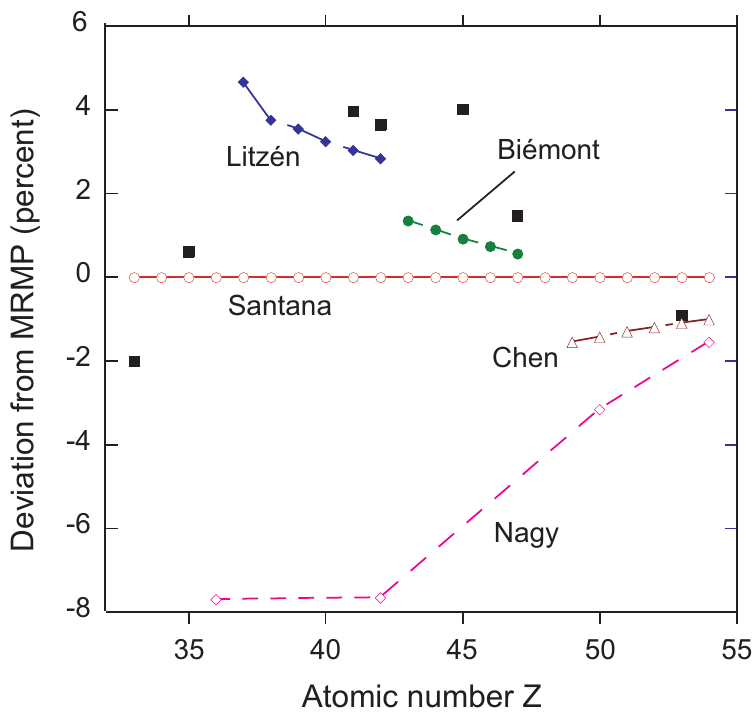
Figure 9. Deviation of the 4s4p 3 5 S o level in Ge-like ions from the MRMP computational results obtained 2 by Santana [13] (open circles at the zero line). Black squares refer to experiments [21,48,51–53,55,56,107] (for As and Br, the error bars are smaller than the symbol size; for Z ≥ 41, all experimental entries are from more or less tentative line identifications and thus depicted without error bars); all other entries refer to computations: Litzén and Reader (blue diamonds) [67] and Biémont et al. [70] (full green dots) are based on semi-empirically-adjusted Cowan code calculations (apparently with different adjustments, which cause the discontinuity of the isoelectronic trends between the two datasets); Nagy and El Sayed (open red diamonds) [68] and Chen and Wang (open mauve triangles) [72] use ab initio MCDF